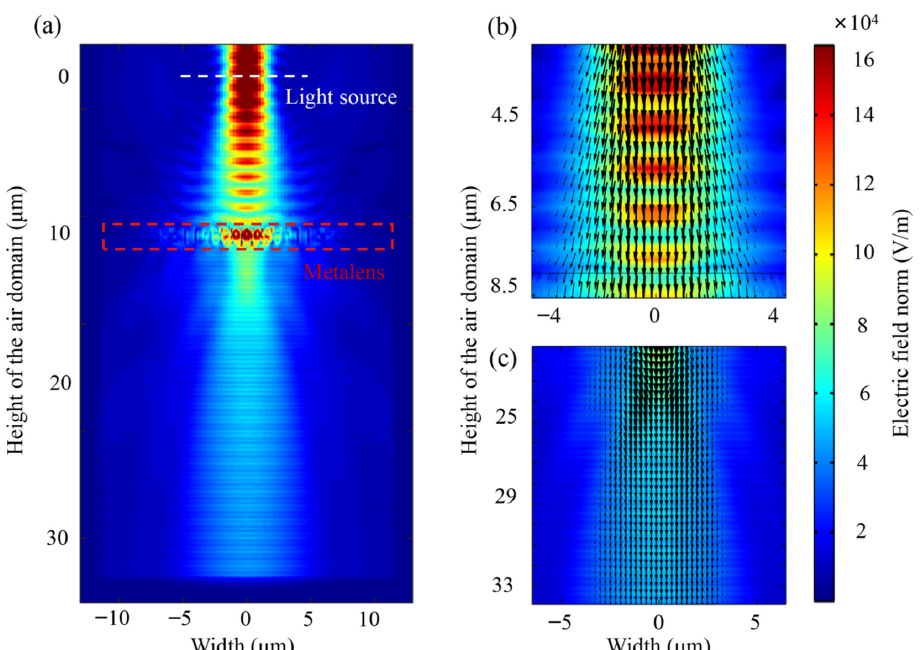
Figure 3. Simulated electric field norm intensity profiles ( y - z plane) of the metalens designed at a wavelength of 1.817 μ m focal length of 10 μ m. ( a ) Electric field intensity profiles ( y - z plane) of the metalens designed at a wavelength of 1.817 μ m and focal length of 10 μ m, the position of the light source and the metalens are shown in the white and red dotted lines, respectively. The black arrows indicate wave vectors of ( b ) the incident and ( c ) the output field.